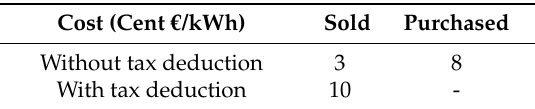
Table 4. Electricity cost for sold and purchased electricity with and without the tax reduction incentive scheme.